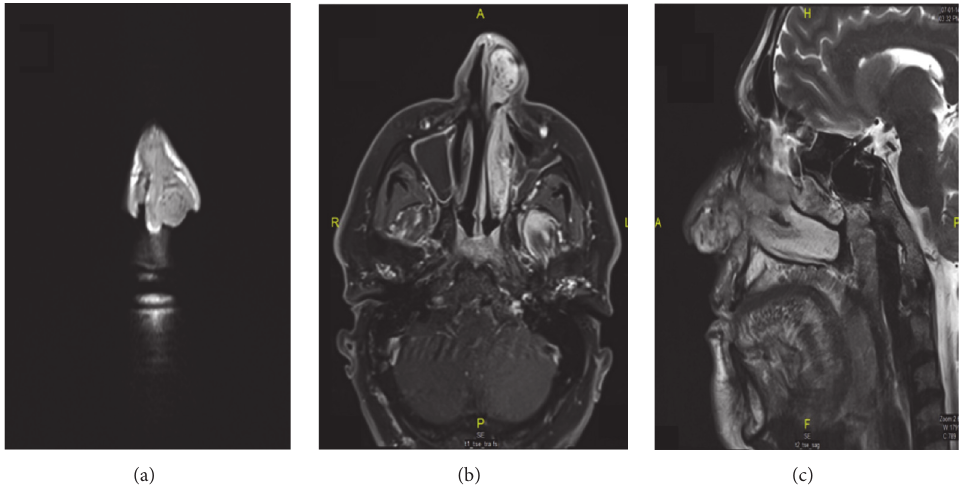
Figure 2: MRI of nose and paranasal sinuses showing a highly vascular mass occupying the left nasal vestibular area. (a) shows T1 coronal view, (b) shows T1 postcontrast axial view, and (c) shows a T2 sagittal